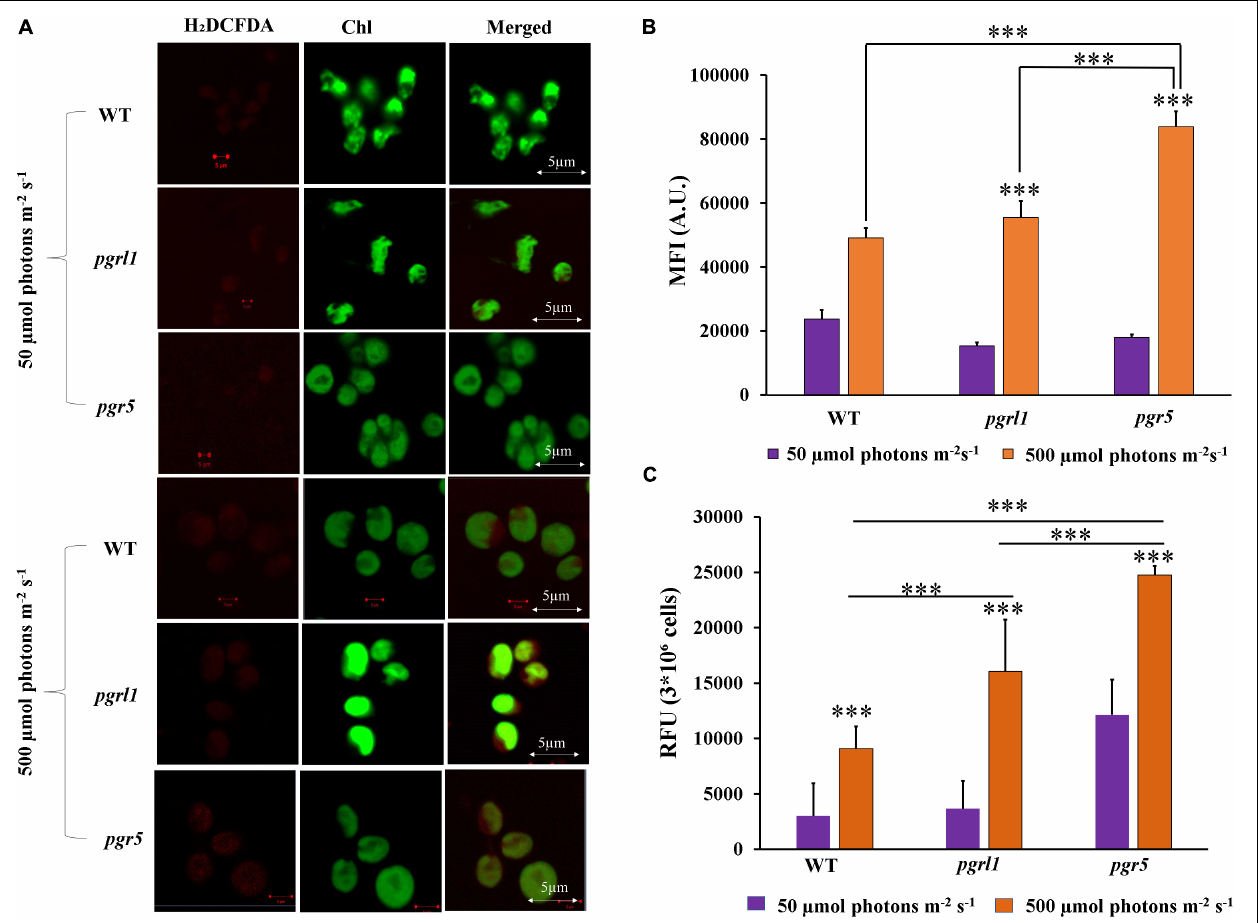
FIGURE 3 | Total Reactive oxygen species (ROS) were measured with H 2 DCFDA. (A) C. reinhardtii cells of WT, pgrl1 and pgr5 were collected from the mid-log phase grown under normal (50 µ mol photons m − 2 S − 1 ) and high light (500 µ mol photons m − 2 S − 1 ) for 3rd day. Measured ROS using 2,7dichlorodihydrofluorescein diacetate (H 2 DCFDA) (10 µ M) staining, and cells were imaged using the Zeiss 510 confocal microscope. The images were collected with three individual measurements for all the conditions ( n = 3) and analyzed with Zeiss software. Scale bars = 2 µ m. (B) Quantification of the fluorescence intensity done by ImageJ. (C) Total ROS was also quantified by spectrophotometry of WT, pgrl1 and pgr5 grown under light condition of 3rd day. Three individual measurements were performed for all the conditions ( n = 3). Statistical significance was analyzed using one-way ANOVA with Tukey test and the p -value obtained are indicated ( ∗∗∗ p <